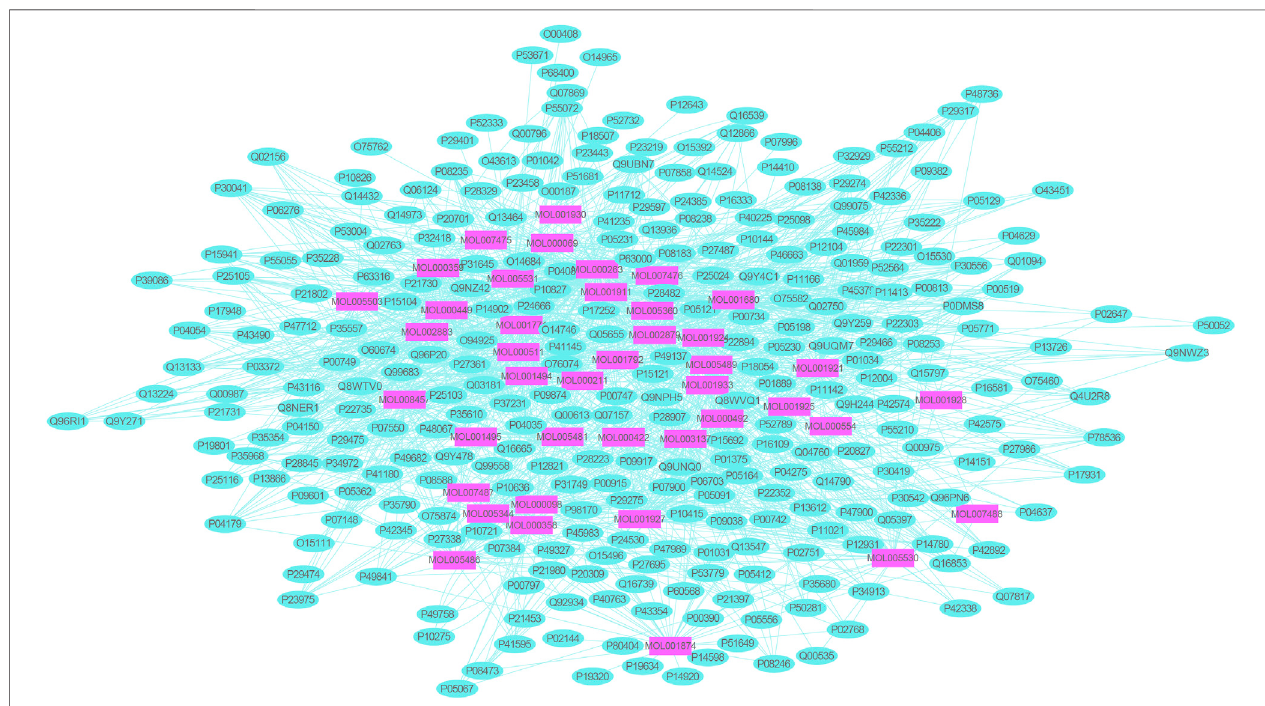
FIGURE 4 | Network diagram of mutual mapping between components and HIRI. In the fi gure, the pink rectangle represents the component target gene, the blue oval represents the HIRI target gene, and the light blue color line represents the intersection line between the component and the target gene.